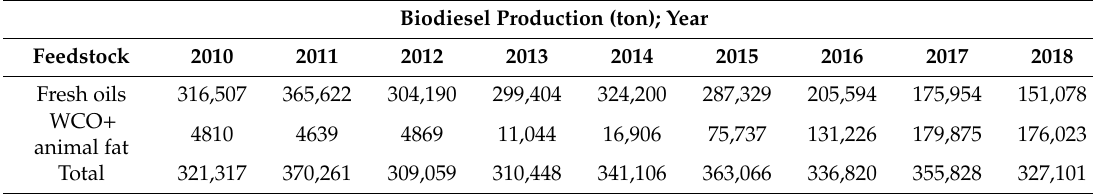
Table 1. Biodiesel production from di ff erent feedstocks in Portugal (adapted from [13]). Biodiesel Production (ton);